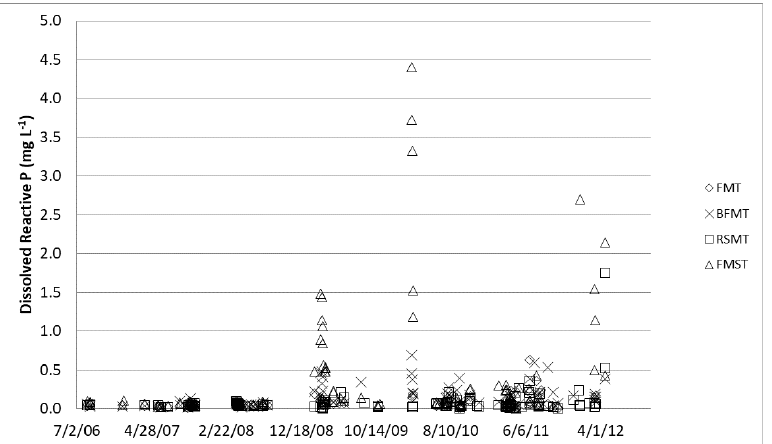
Figure 4. Concentrations (mg L − 1 ) of dissolved reactive P (DRP) over the study period. Broadcast application of manure in the fall with tillage delayed until spring (FMST) leaves manure on the soil surface through the non-growing season, resulting in marked water quality contrasts between rain and snowmelt runoff. In rain events, the small (11%) reduction in SS concentration led to 17% and 2% decreases in TN concentration and load, respectively, but no other decreases. There were increases in DRP and NH 4+ -N concentration of about 70% and loads of 190 and 16%, respectively. In snowmelt runoff, there were significant decreases in SS, TN, and NO 3 -N concentrations and SS and NO 3 -N load. Perhaps the most striking effects were the very large increases in TP, DRP, and NH 4+ -N (579, 647, and 232% concentrations, respectively, and 605, 784, and 411% loads, respectively), emphasizing the runoff water quality risk posed by unincorporated manure left on the soil surface over winter.